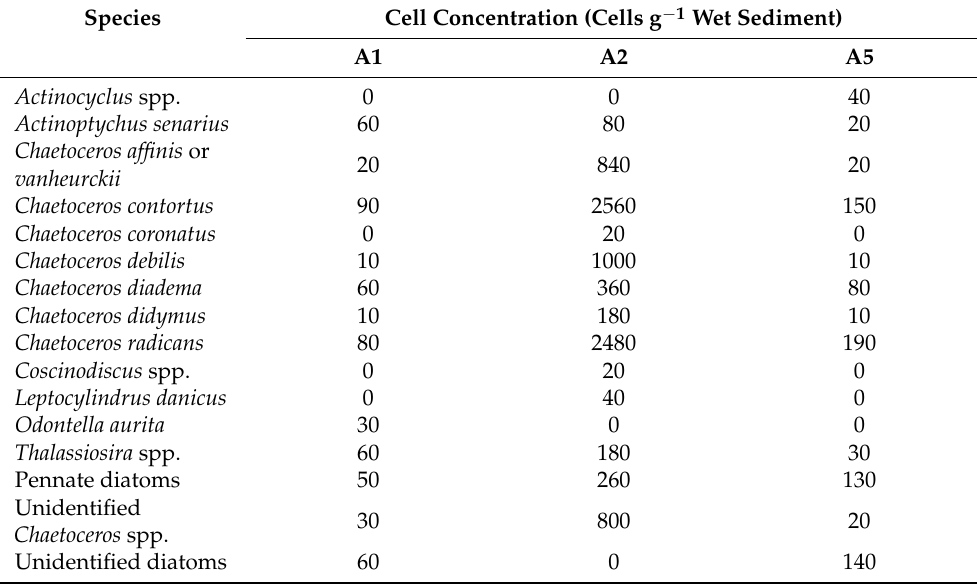
Table 3. Taxa and concentrations of the diatom resting stages in the bottom sediment at A1, A2, and A5, determined by direct microscopic observation. Cells of species other than pennate diatoms and unidentified diatoms were identified as resting stages in the present study.